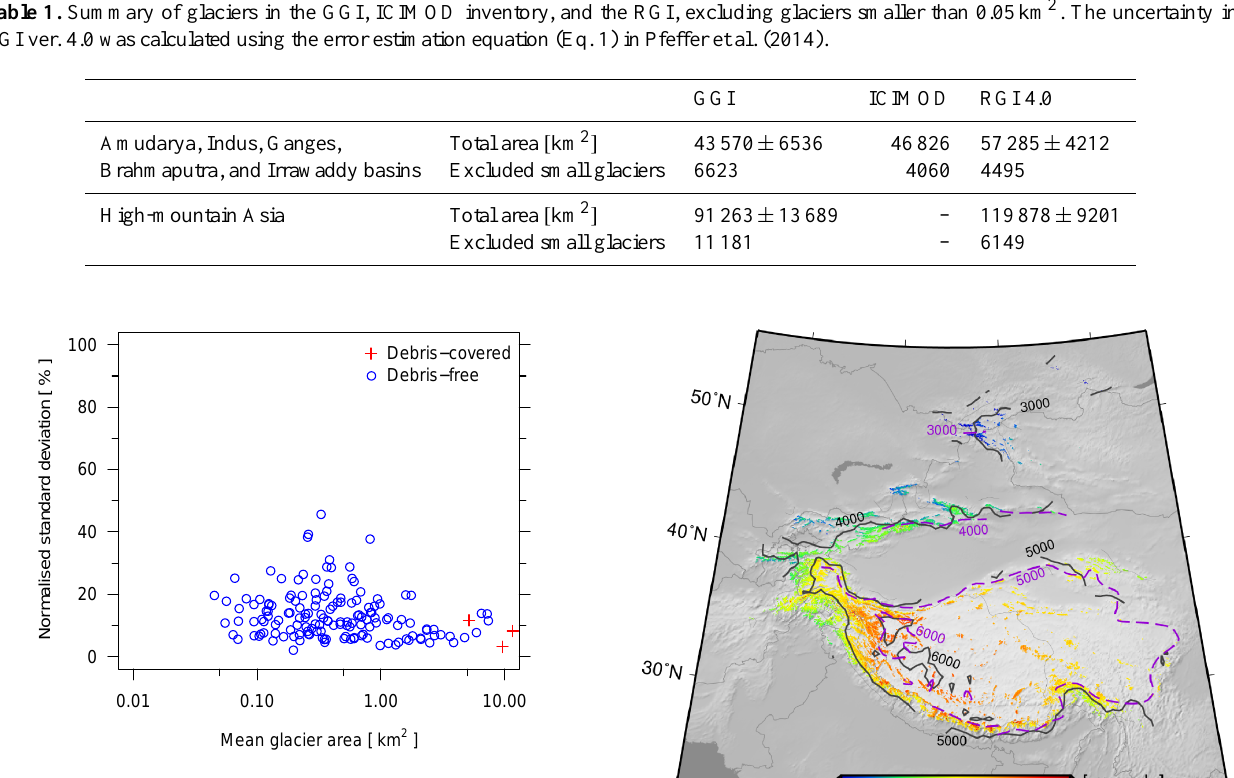
Figure 12. Normalised standard deviation of glacier area, based on delineations by different operators divided by the mean glacier area for all operators.